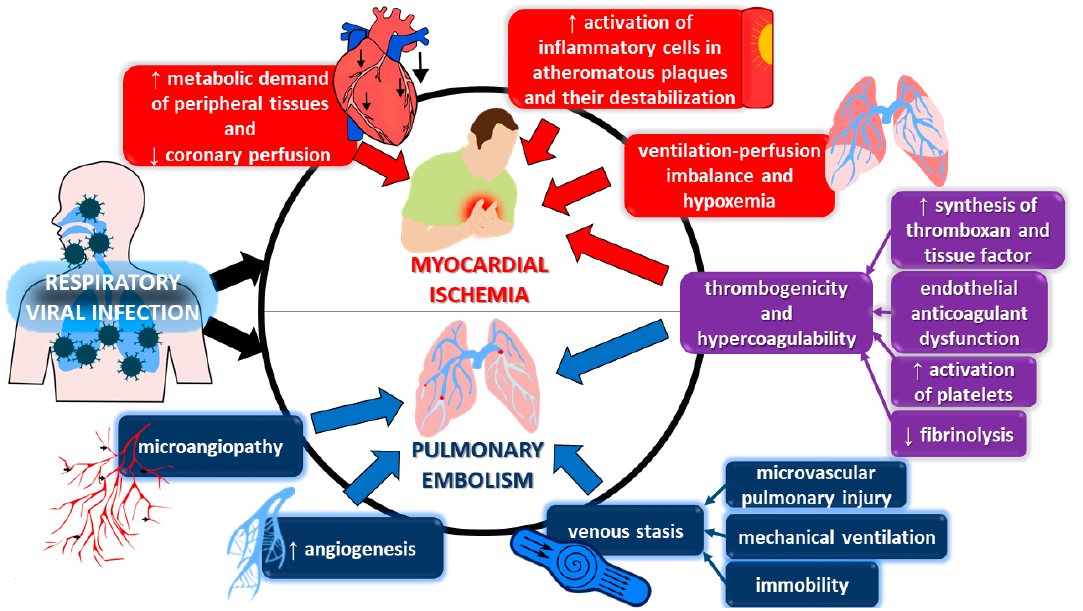
Figure 2. Multifaceted and overlapping mechanisms of arterial ischemic and venous thromboembolic complications of viral respiratory